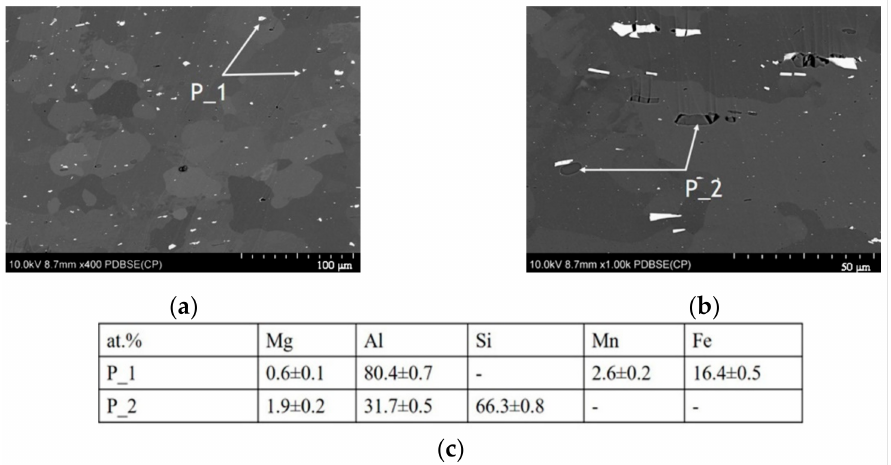
Figure 2. SEM images of the microstructure of the AA5457 sheet in the undeformed area (A): ( a ), an image showing the overall distribution of intermetallic particles, ( b ), image showing the morphology and surrounding area of intermetallic particles, and ( c ), chemical analysis of the intermetallic particles P_1 and P_2 marked in panels a and